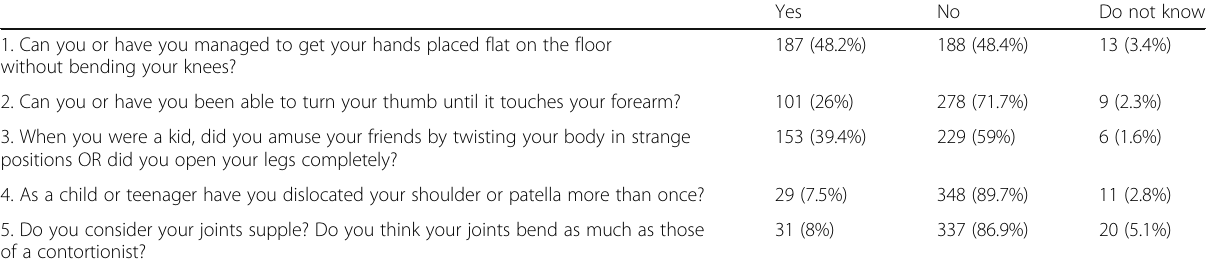
Table 1 Frequencies of responses on hypermobility, described in a 5-item questionnaire for joint hypermobility [41]